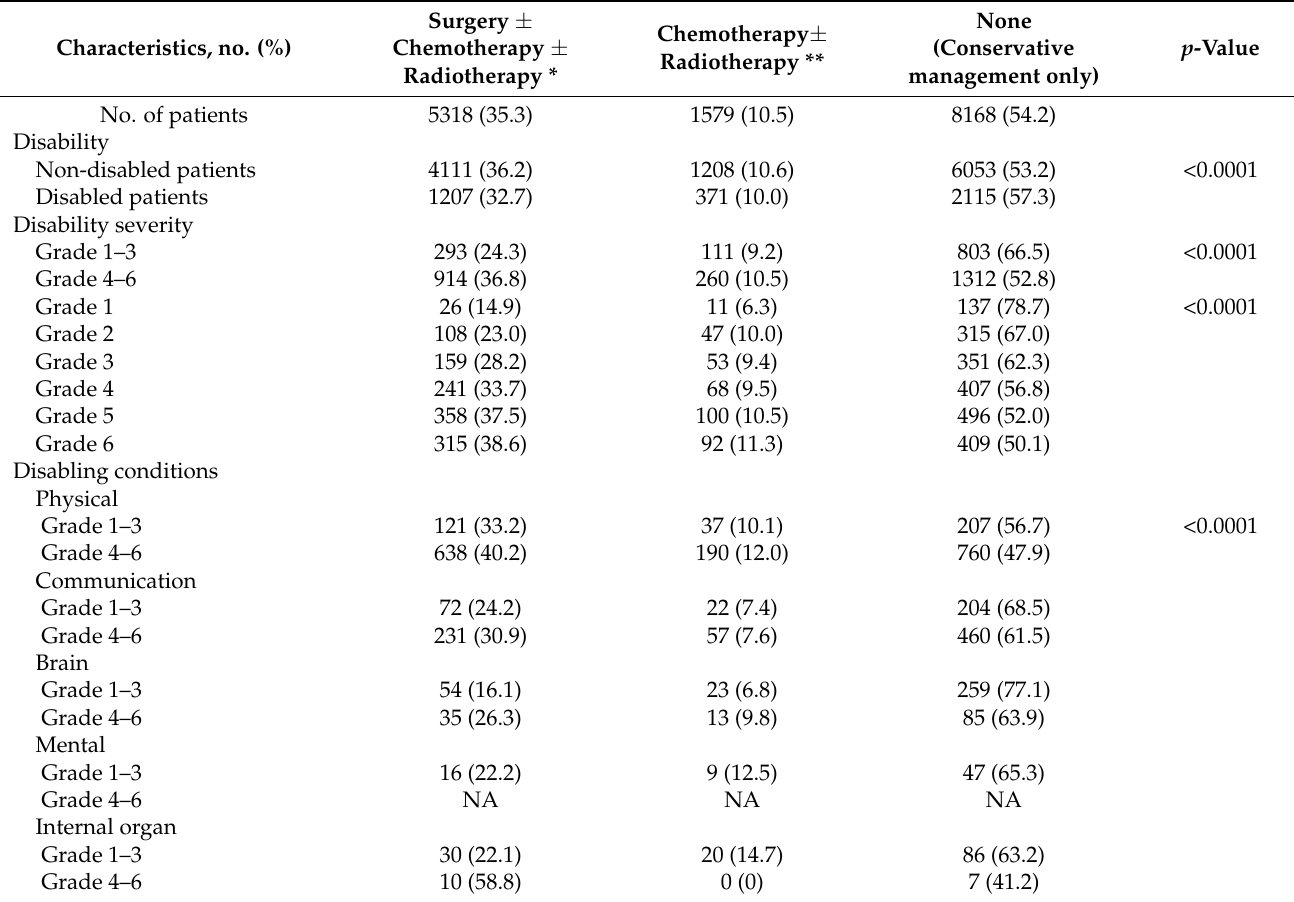
Table 3. Treatment patterns according to the disability characteristics in patients with bile duct cancer.